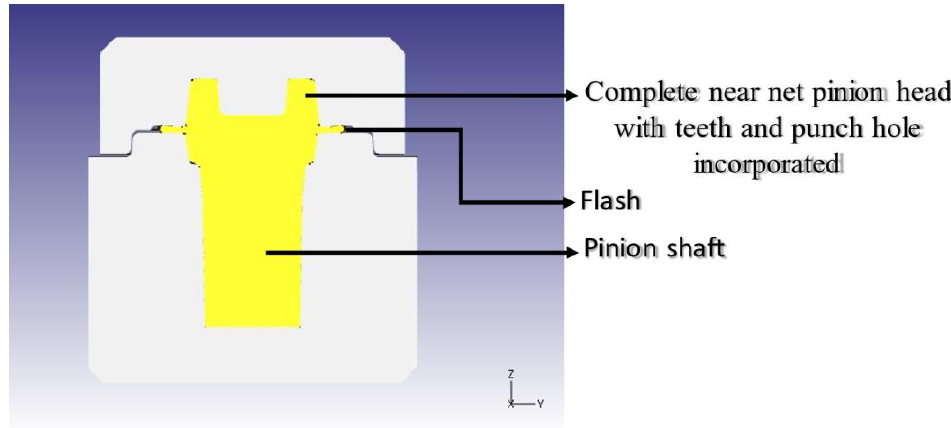
Figure 17. Near-net pinion shaft with teeth and multilevel head.